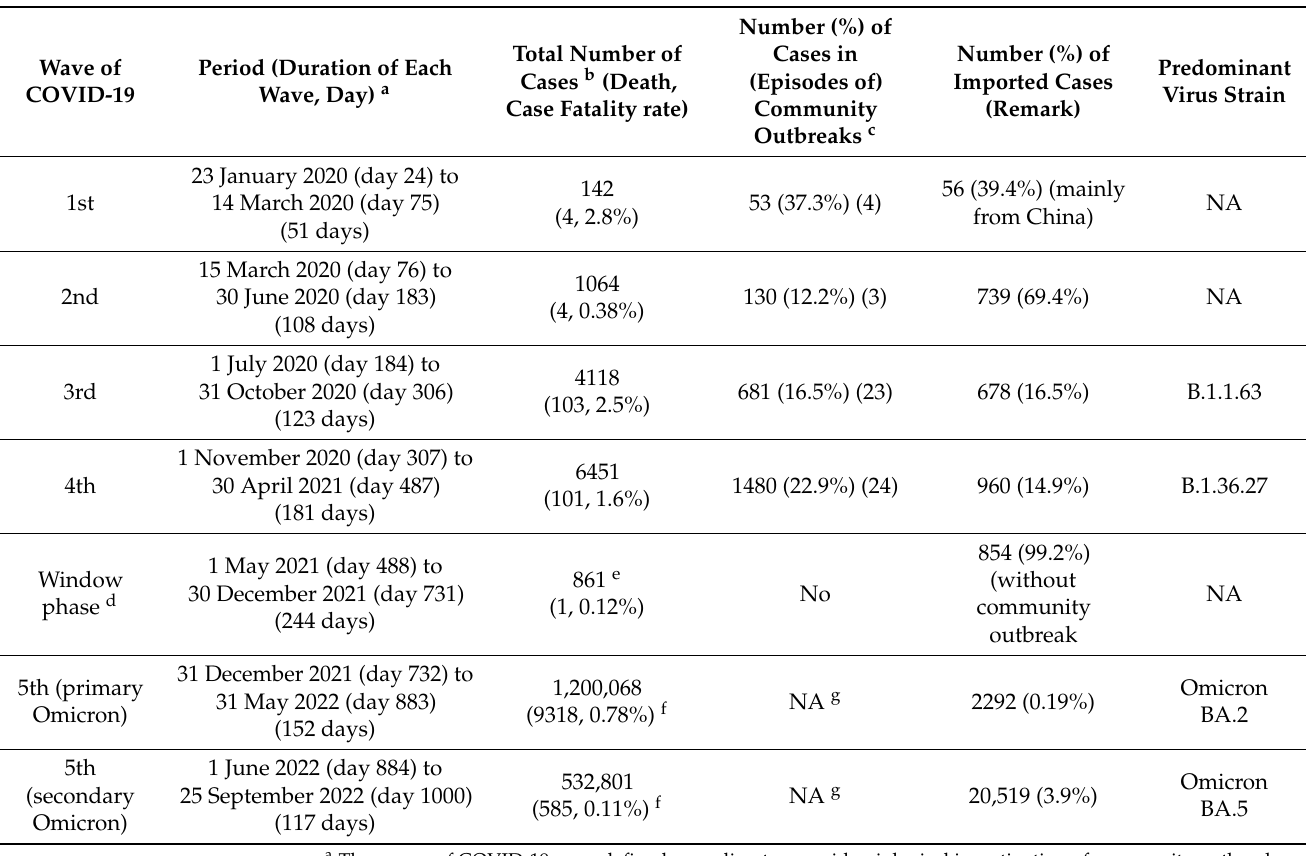
Table 3. Epidemiological and virological characteristics in different waves of COVID-19 in Hong